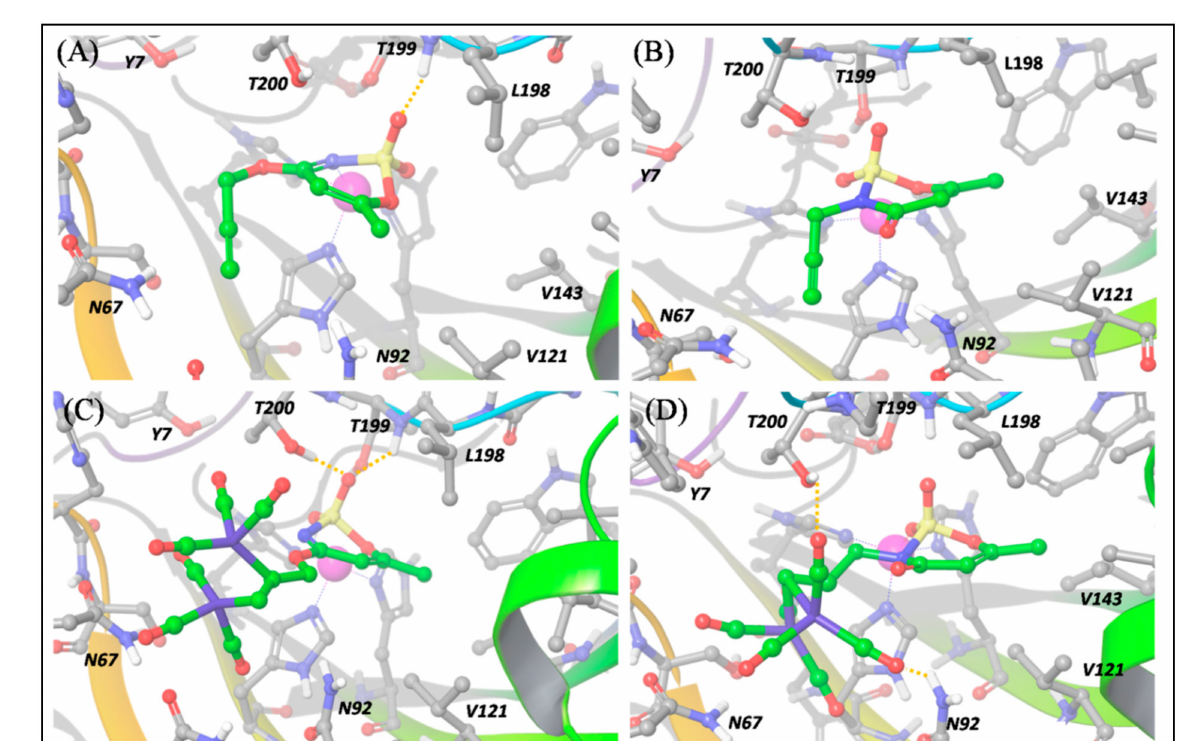
Figure 6. Predicted binding poses of a (panel ( A )), b (panel ( B )), 1 (panel ( C )) and 2 (panel ( D )) into hCA IX-mimic pocket. Hydrogen bond interactions are reported by orange dotted lines. The Zn 2+ ion is represented as a purple